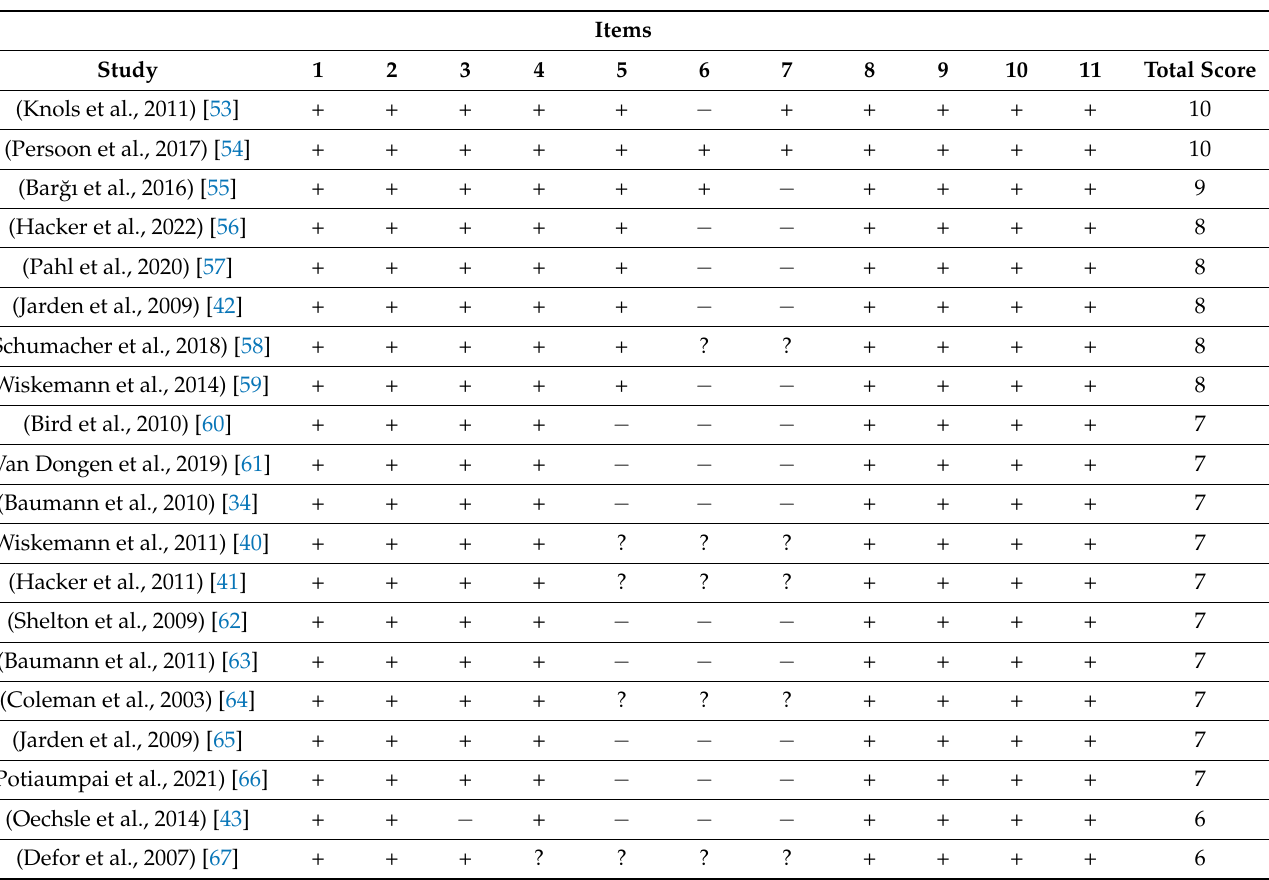
Table 1. Quality of the studies included in the systematic